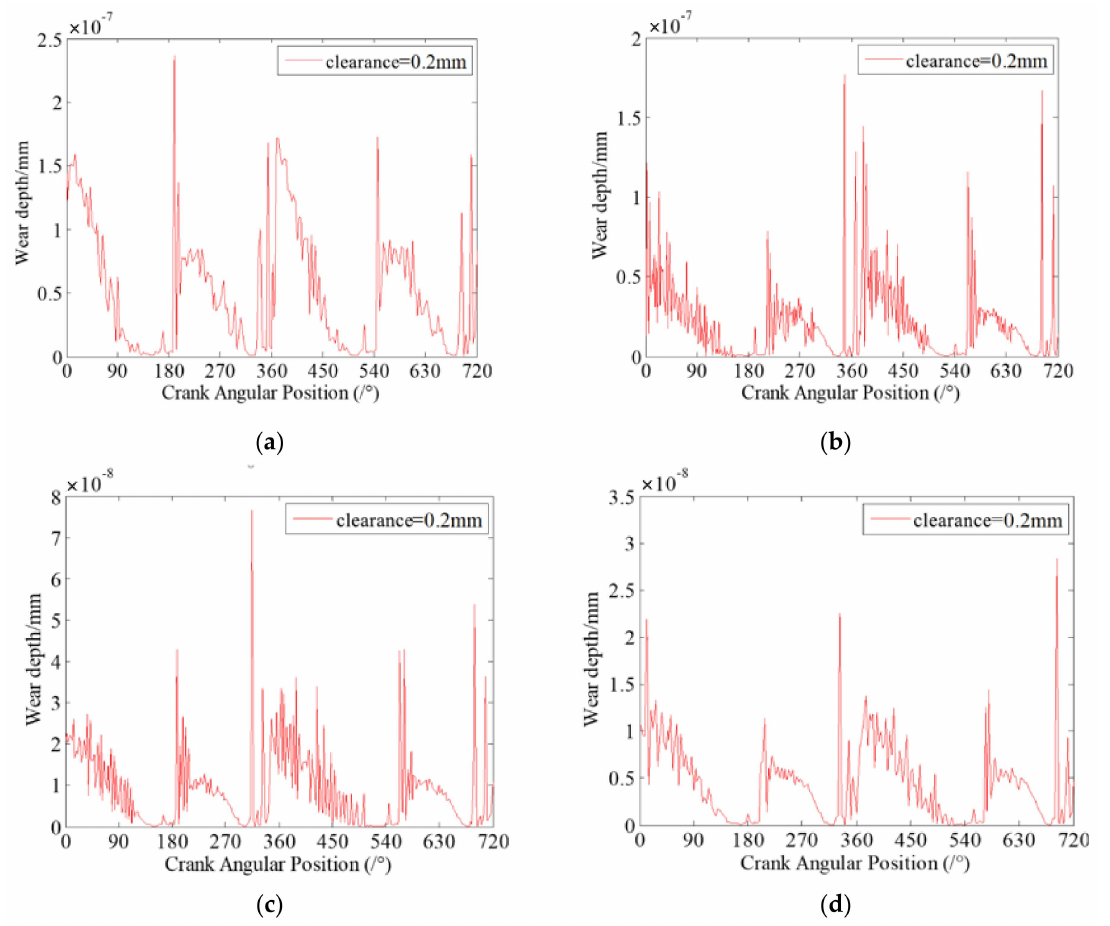
Figure 9. Dynamic wear depth in revolute clearance joint A for different cases. ( a ) 1 × 10 6